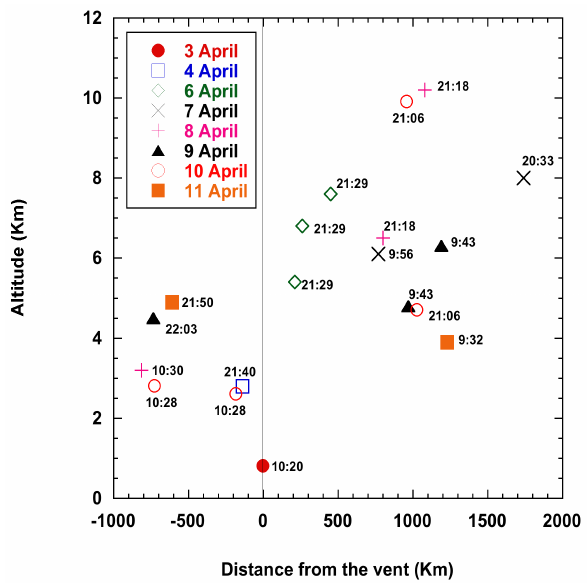
Fig. 3. Altitude and distance from La R´eunion of the aerosols Fig.3. AltitudeanddistancefromLaR´eunionoftheaerosolsplumesobservedbytheCALIOPsensorontheCALIPSOsatellitefromApril plumes observed by the CALIOP sensor on the CALIPSO satellite 3toApril11,2007atdifferenttimes(plotted). Negativeabcissavaluescorrespondtothewest,andpositivevaluestotheeast. from 3 April to 11 April 2007 at different times (plotted). Negative abcissa values correspond to the west, and positive values to the